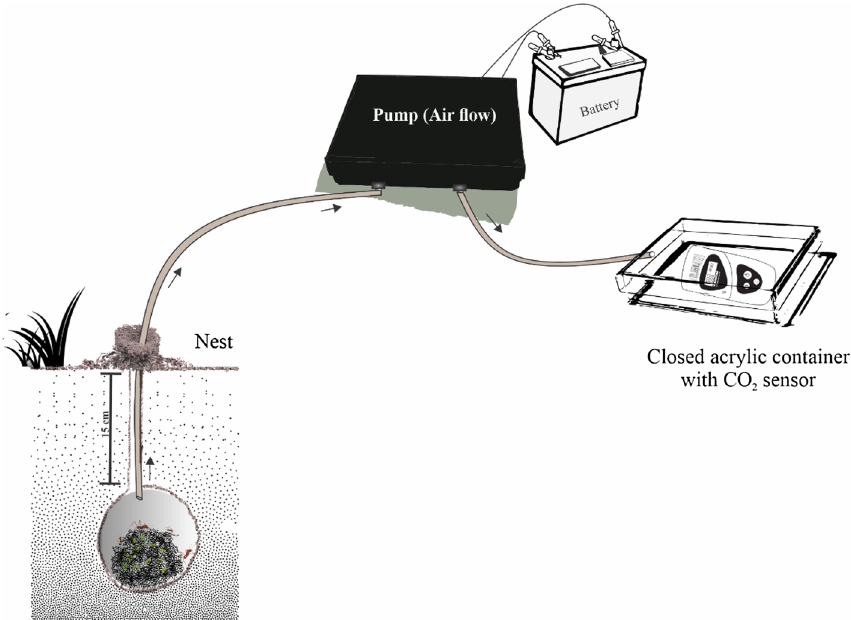
Figure 2. Scheme of the closed respirometric system used in the experiment to measure CO 2 in nests of Atta sexdens (Hymenoptera: Formicidae) in field. Design created by Kátia K. A. Sousa by CorelDRAW 2019 (https:// www. corel draw. com/ br/? link=